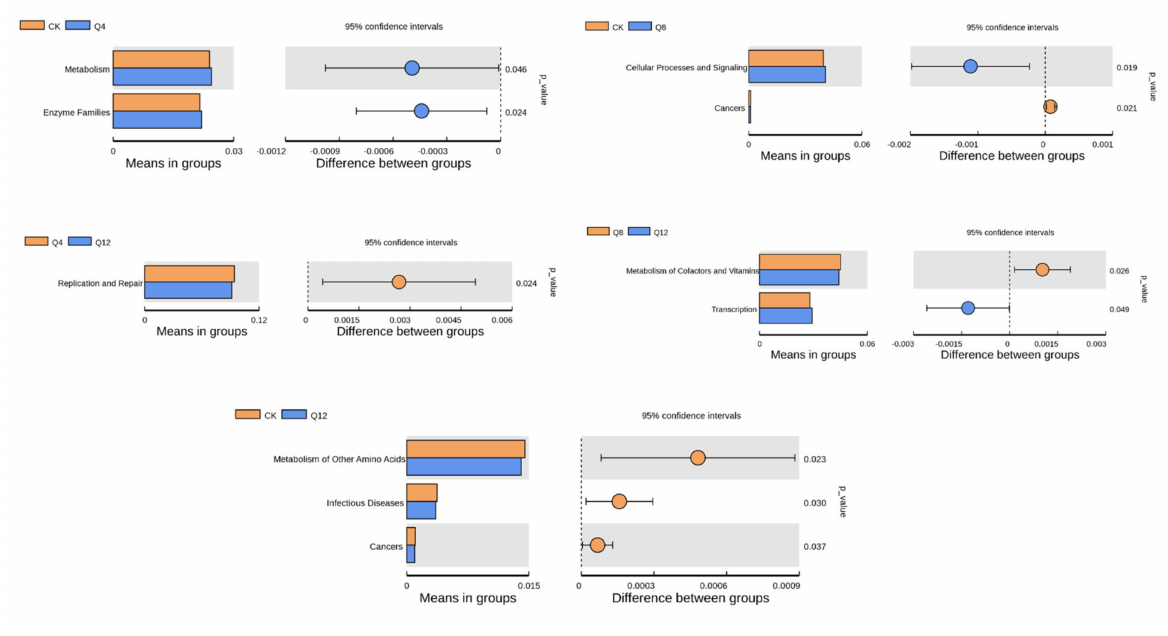
Figure 5. Function prediction analysis.